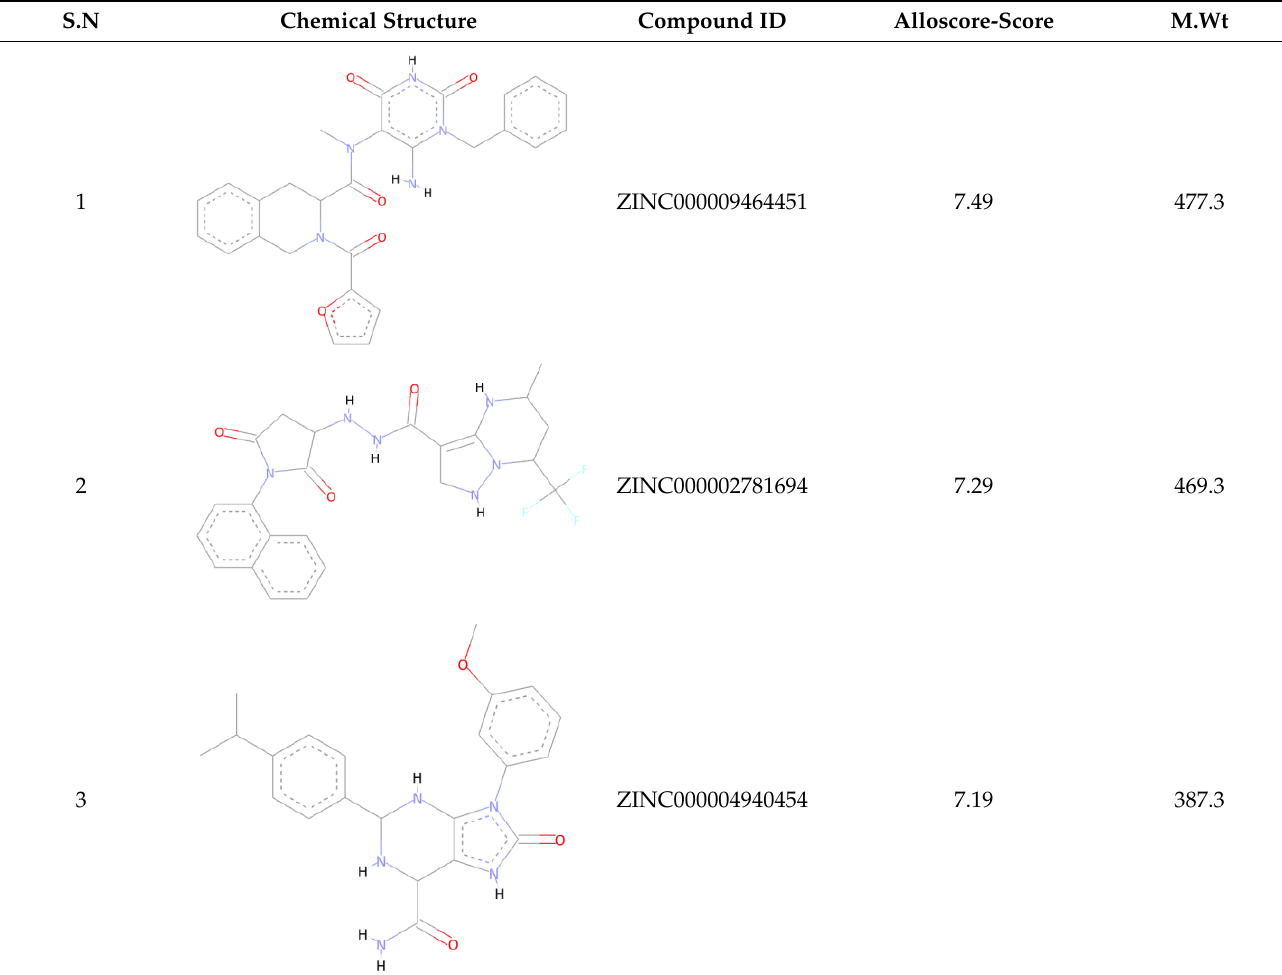
Table 2. Chemical structures, compound IDs, their Molecular weights and alloscore-score ranking from ZINC Diversity Library.